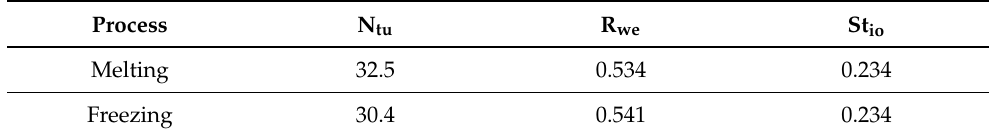
Table 8. Thermal Energy Storage Prototype Dimensionless Variable Values. Process N tu R we St io Melting 32.5 0.534 Freezing 30.4